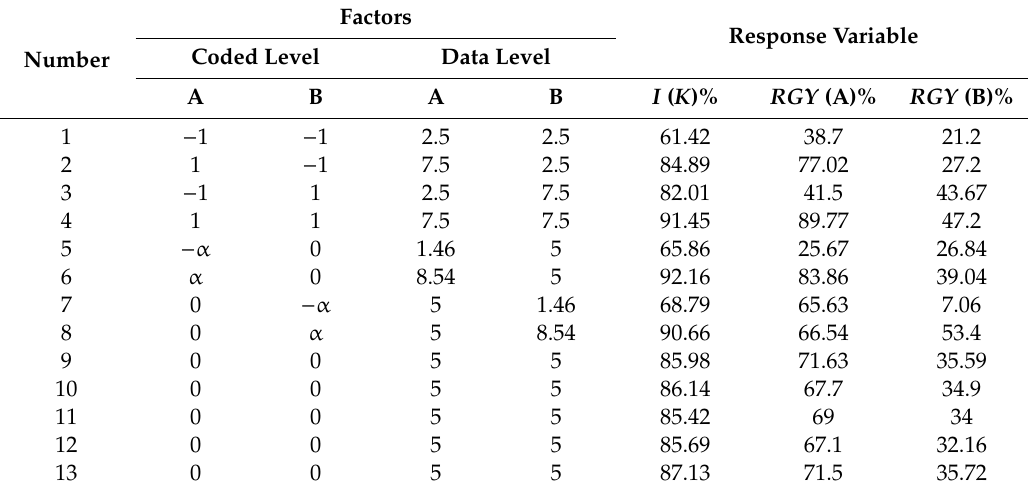
Table 2. Calculation results of central composite design